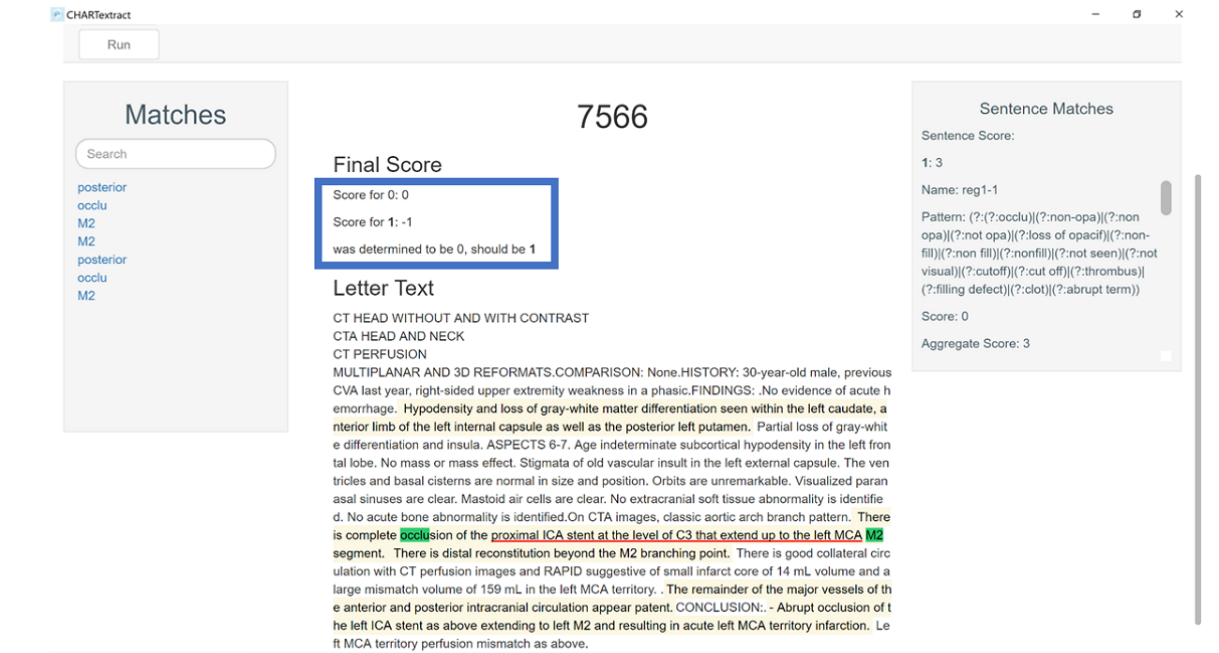
Figure 3. Example 3 of a discrepancy between the chart abstractor and CHARTextract tool output. The abstractor labeled that large vessel occlusion was present because the abstractor was able to interpret that an occlusion from the internal carotid artery and extending to the M2 segment of the middle cerebral artery involves the M1 segment, but the CHARTextract tool determined this attribute to be absent because the tool detects key words without knowledge of vascular